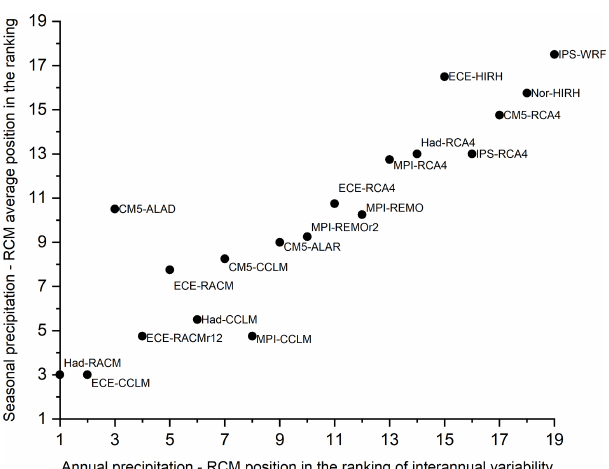
Figure 15. Comparison between the RCM position in the ranking of inter-annual variability of annual precipitation versus the average position in the ranking of seasonal variability of seasonal precipita- tion. Data concern the whole study area (Calabria and